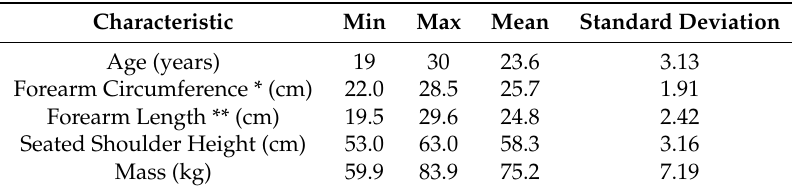
Table 1. Subject